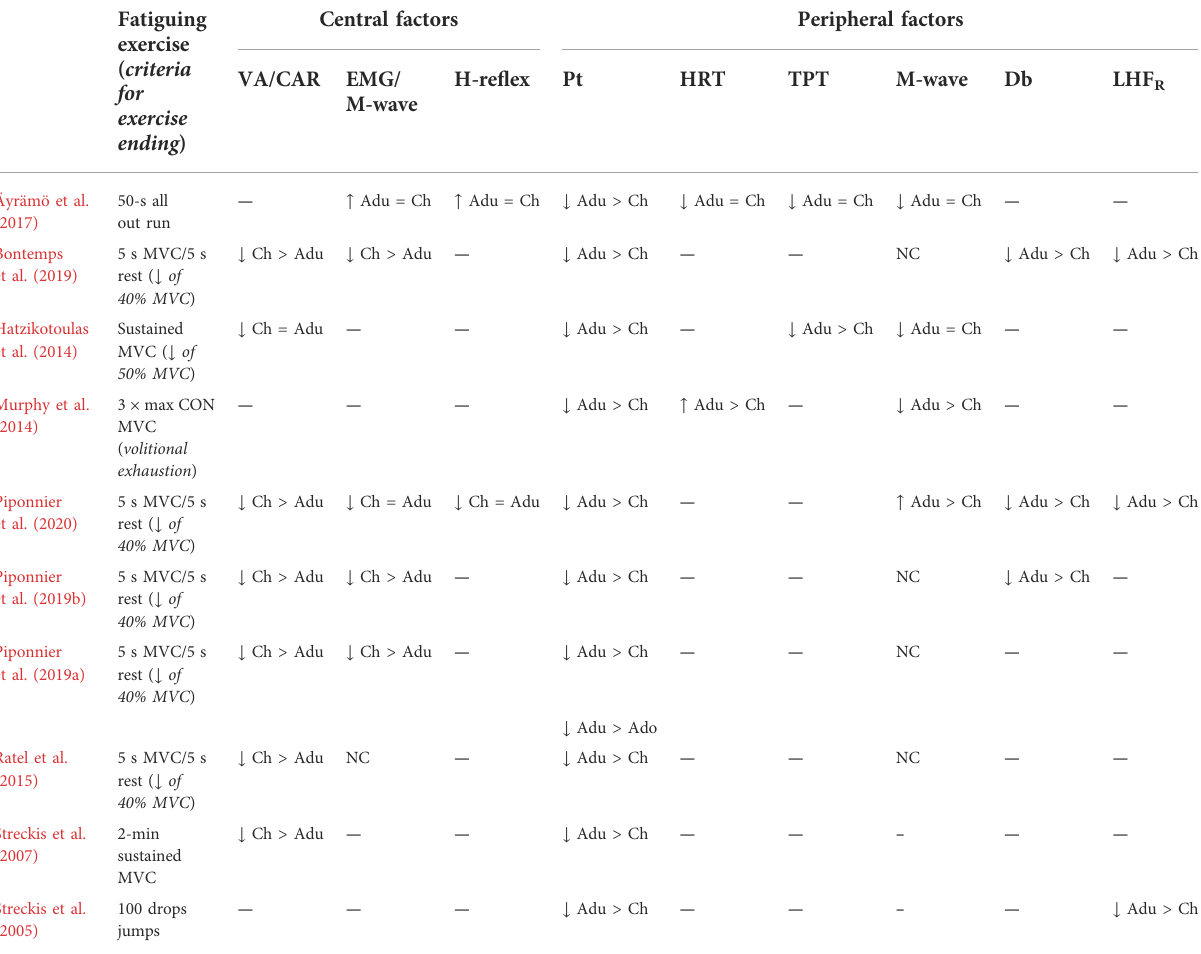
TABLE 3 Central and peripheral fatigue parameters. Fatiguing